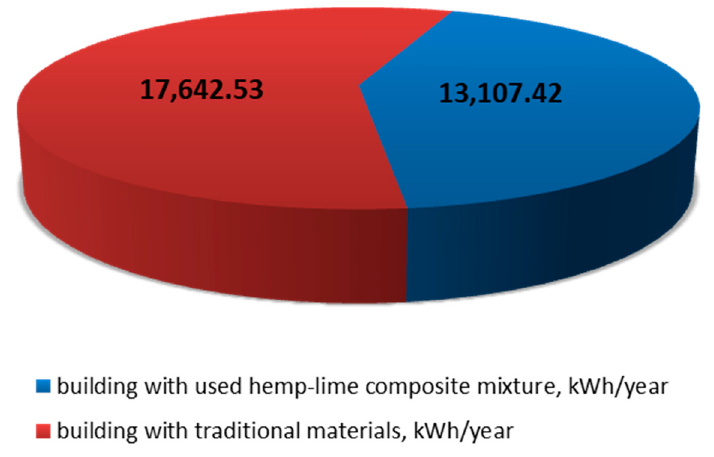
Figure 7. Comparison of total heat losses due to material permeability.